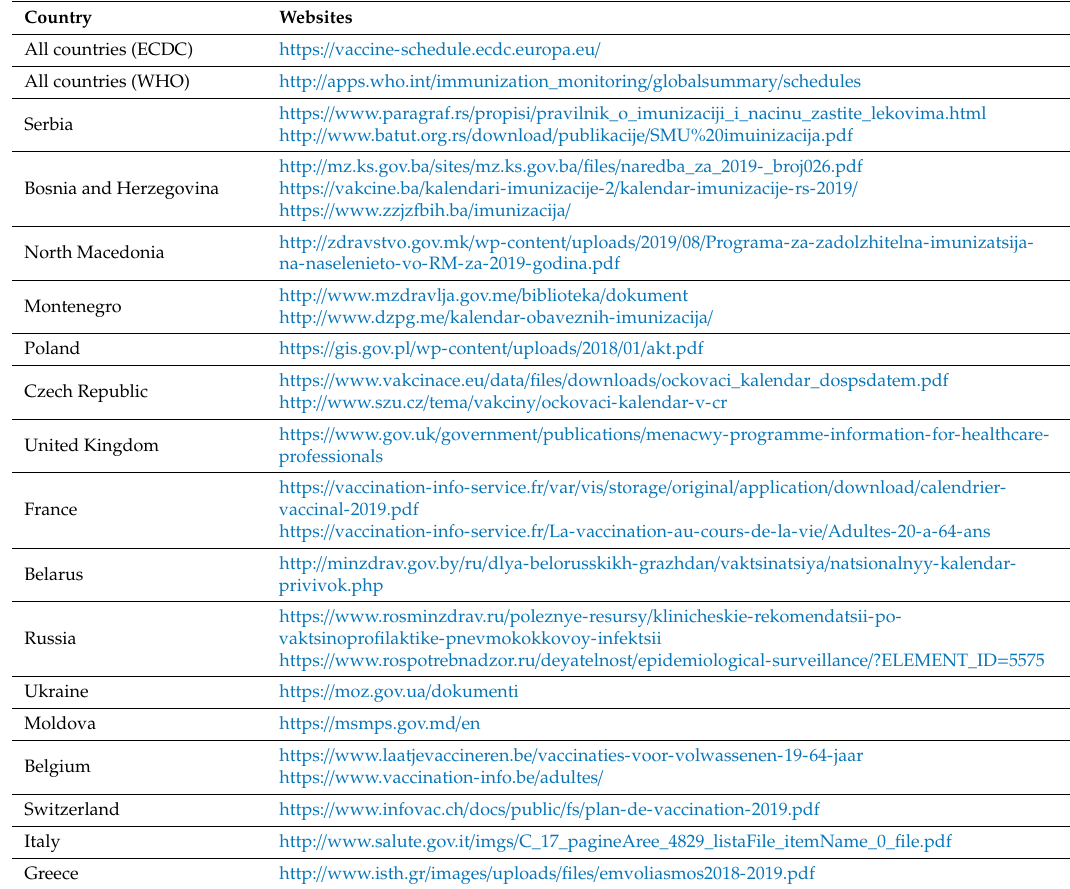
Table 1. Consulted o ffi cial public health